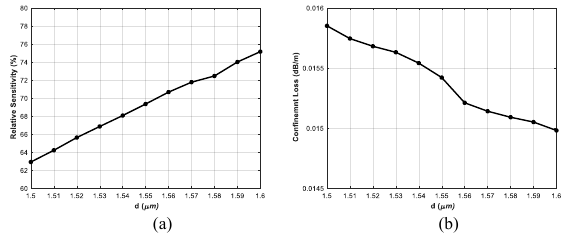
FIGURE 4. Variation of a) the relative sensitivity and b) the confinement loss for different values of d , while other parameters are kept constant.